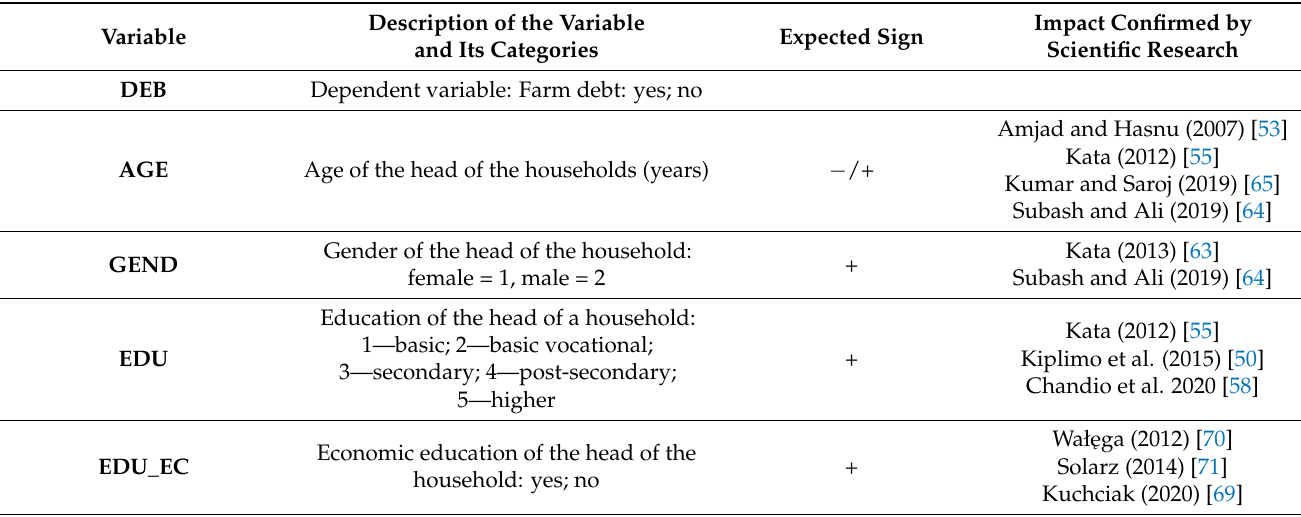
Table 1. Set of potential variables adopted for the